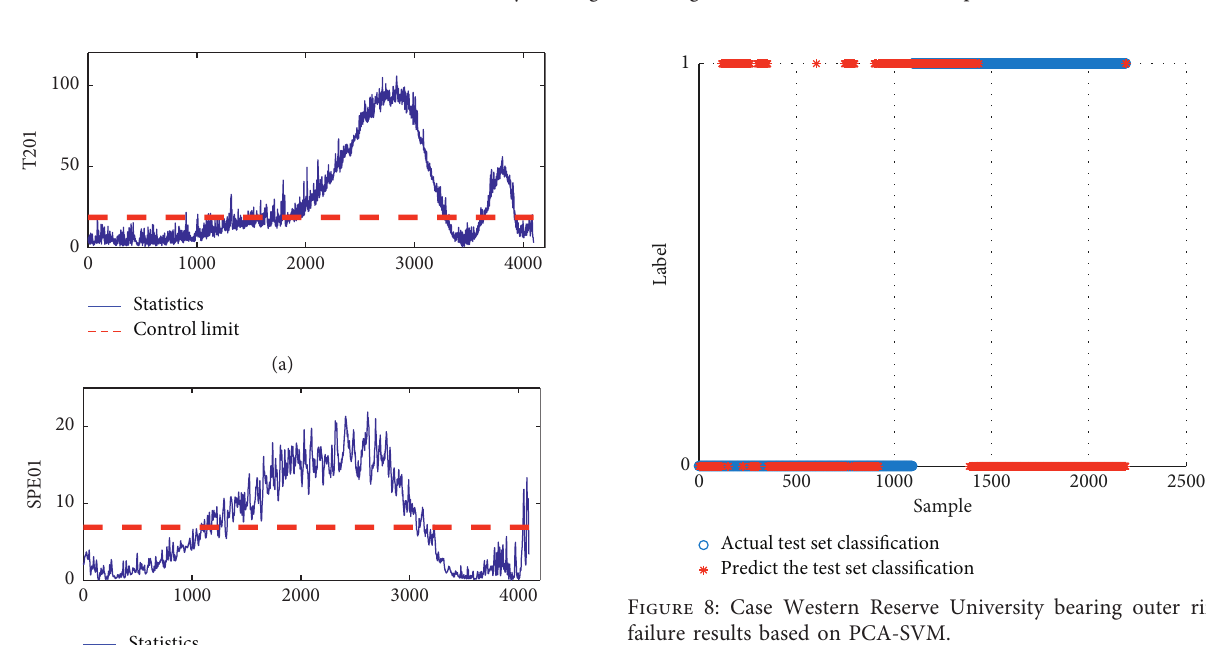
simulation experiment bearing inner ring failure results based on PCA-SVM. Label 0 means normal data, and label 1 means inner ring fault data. The blue circle represents the predicted result, and the red cross represents the actual diagnosis result. We can see from the image that the de- tection rate is about 85%.